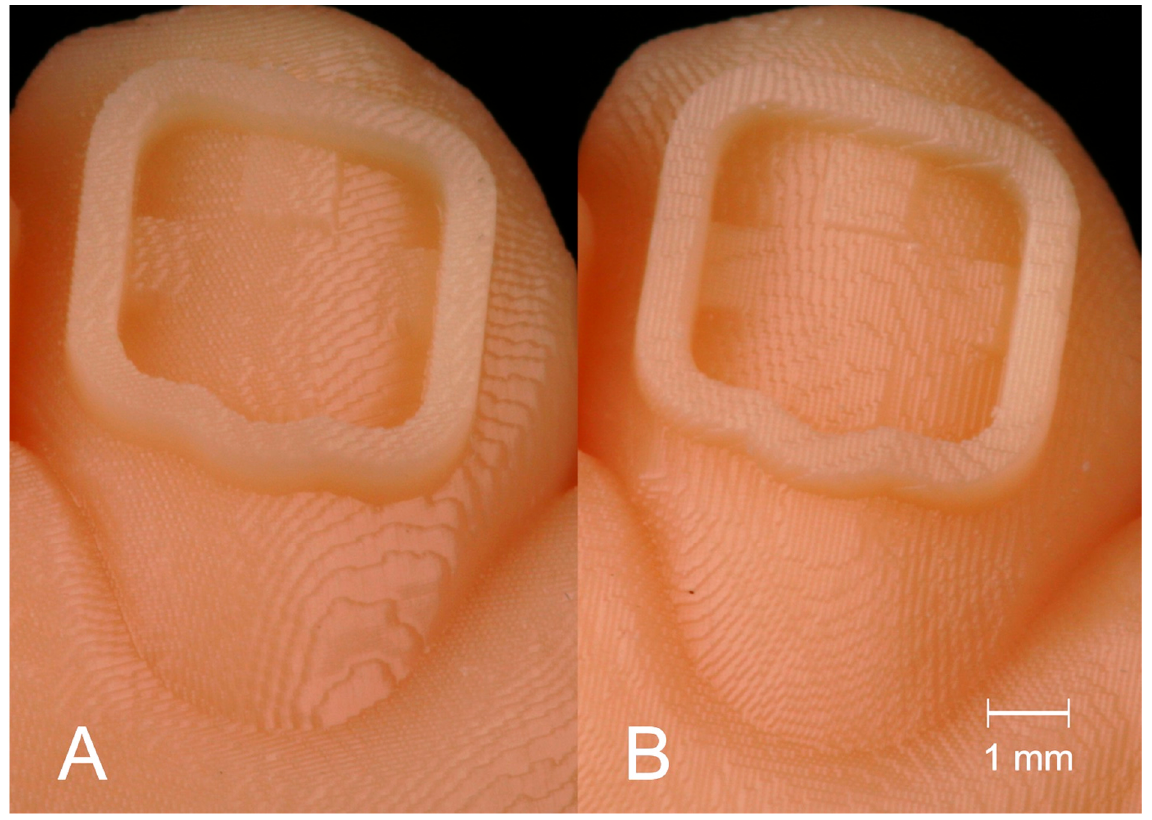
Figure 6. Staircase effect on the surface of the transfer models in Group H ( A ) and Group V ( B ).